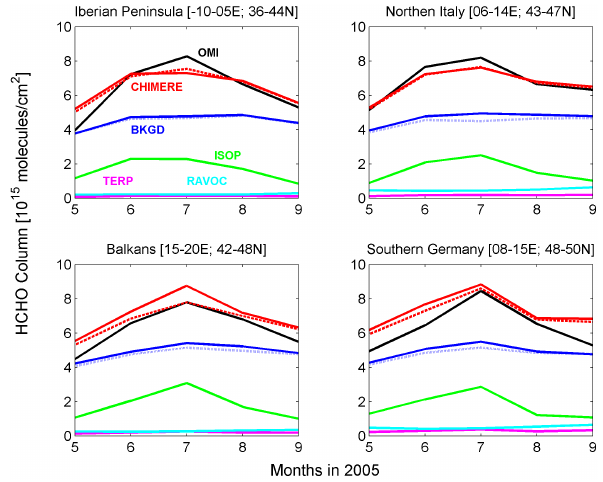
Fig. 3. OMI and model monthly HCHO column (10 15 molecules cm − 2 ) over selected continental European regions during May–September 2005. The black line denotes OMI observations, the red line denotes the CHIMERE model; the continuous red line denotes the model with standard (a-priori) emissions, and the dashed red line denotes the model with OMI-corrected (a-posteriori) emissions. Other lines represent contributions to HCHO column from the oxidation of long-lived hydrocarbons (blue, background, BKGD), isoprene (green, ISOP), terpenes (magenta, TERP), and anthropogenic reactive VOCs (cyan, RAVOC: ethene, propene, and xylenes). The blue dotted line denotes the background HCHO calculated by subtracting the sum of contributions from reactive VOCs from the total model column, and is used to evaluate the uncertainty related to estimate of Jacobian matrix (see text).